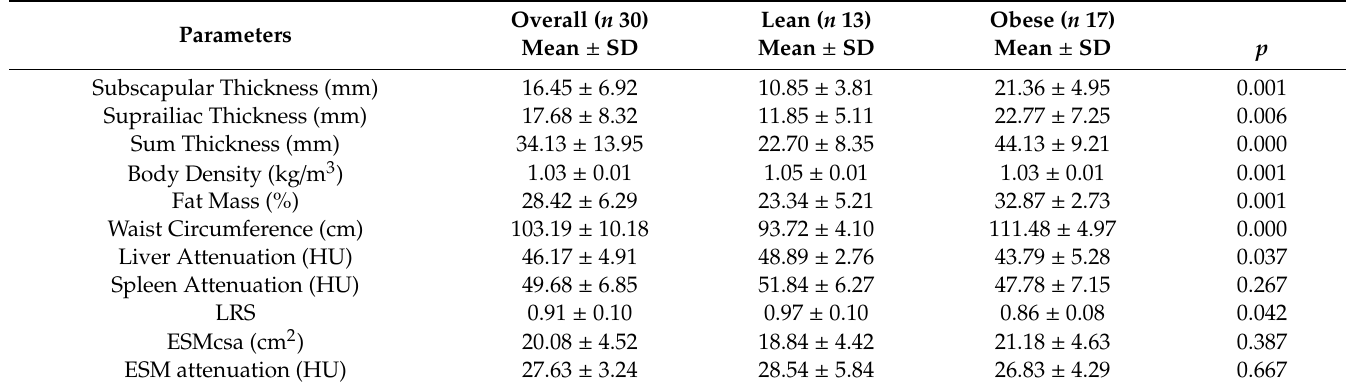
Table 1. Descriptive and Compared between groups at baseline.